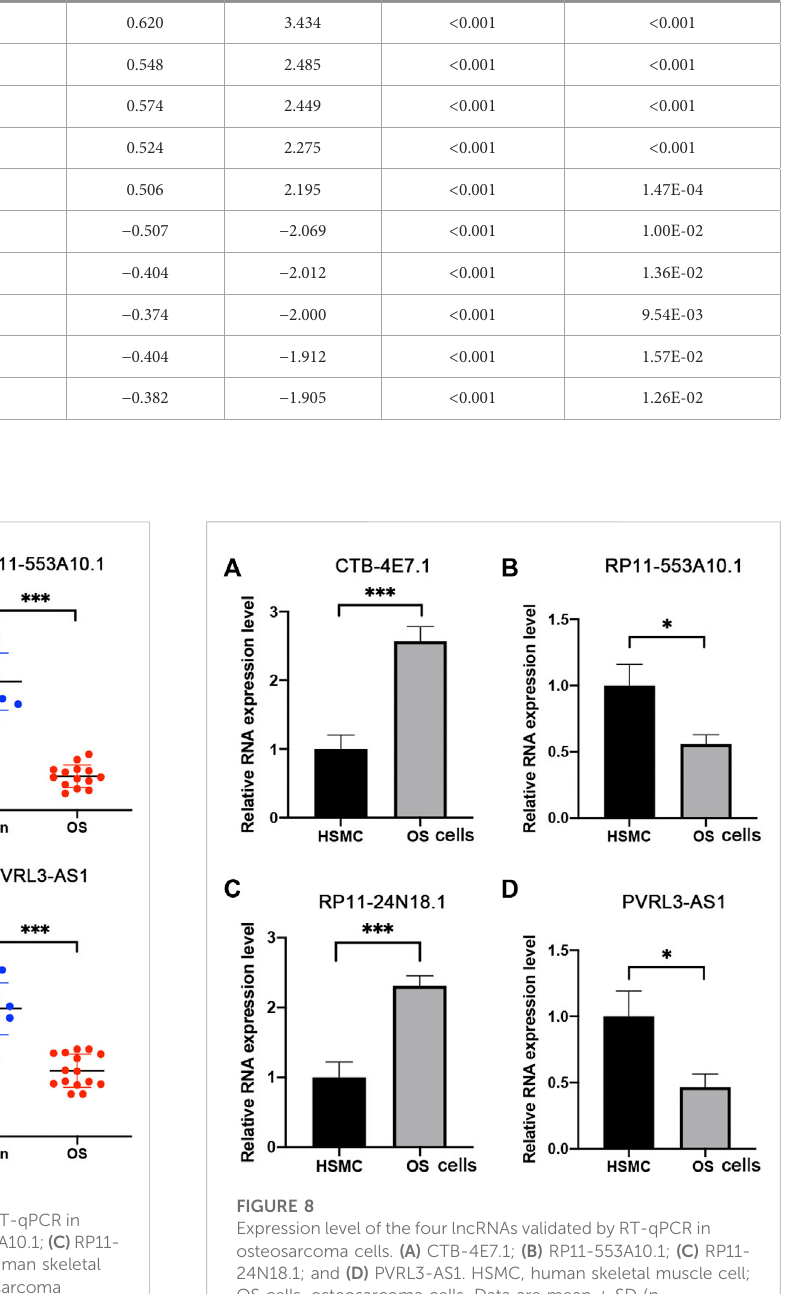
and PVRL3-AS1) were identi fi ed. A four-lncRNA risk signature